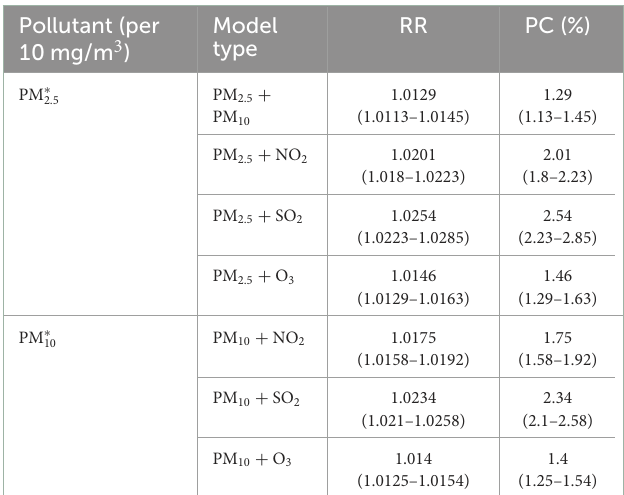
TABLE 5 The RR and percent change of eczema risk associated with 10 mg/m 3 increase of PM 2.5 and PM 10 under two-pollutant